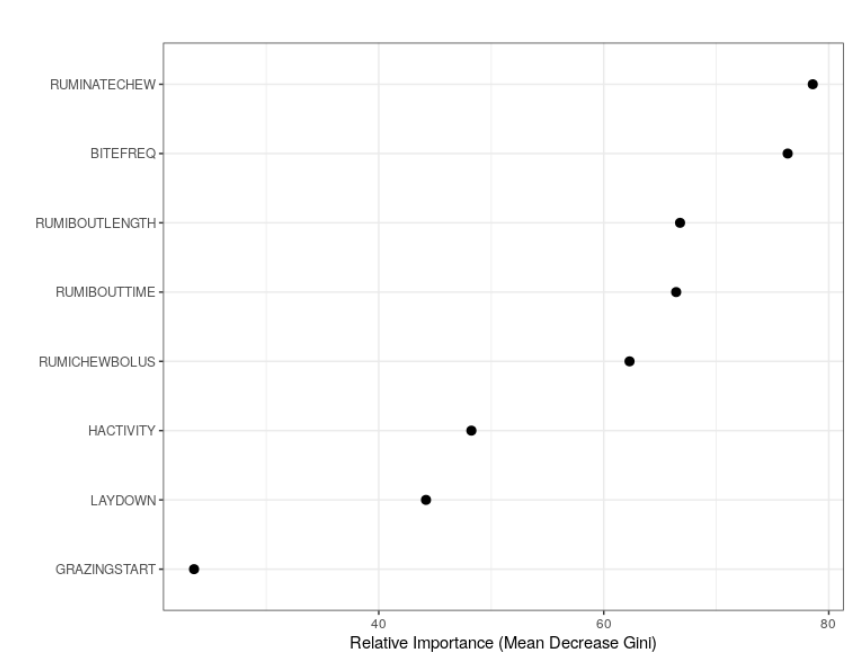
Figure 2. Variable importance plots for random forest based on mean decrease of Gini coefficients.